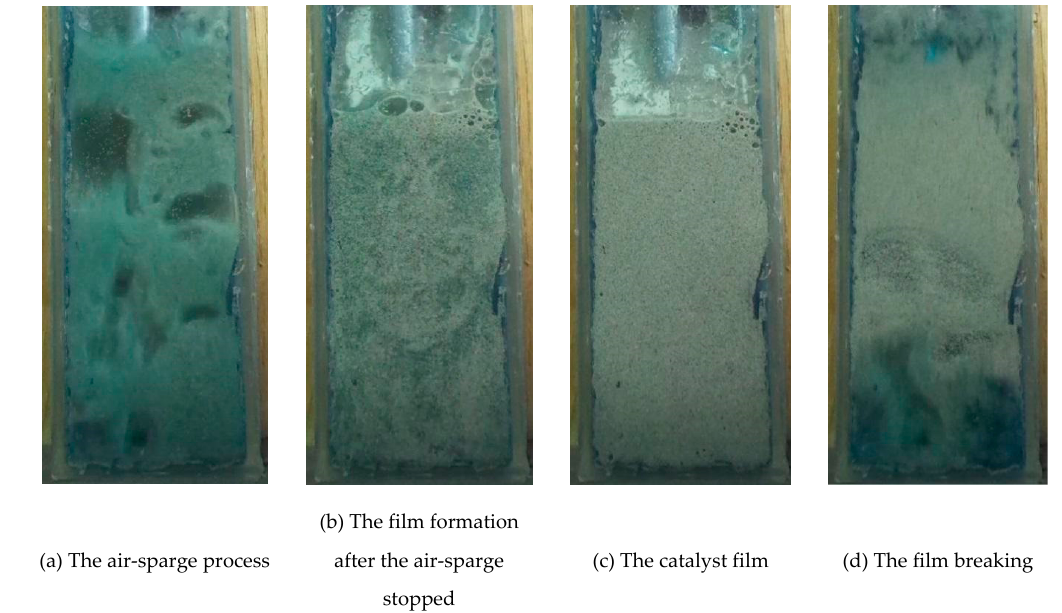
Figure 4. The cyclic process of the catalytic film formation and breaking.